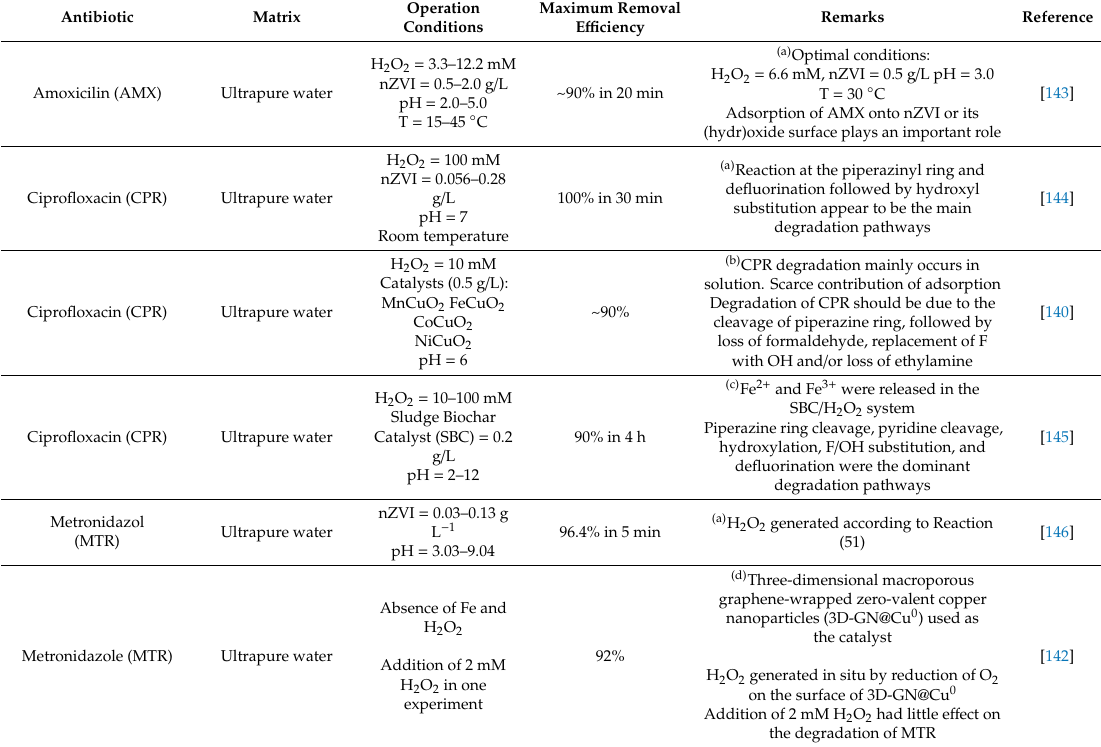
Table 11. Removal e ffi ciency of antibiotics in waters through heterogeneous Fenton-like process.